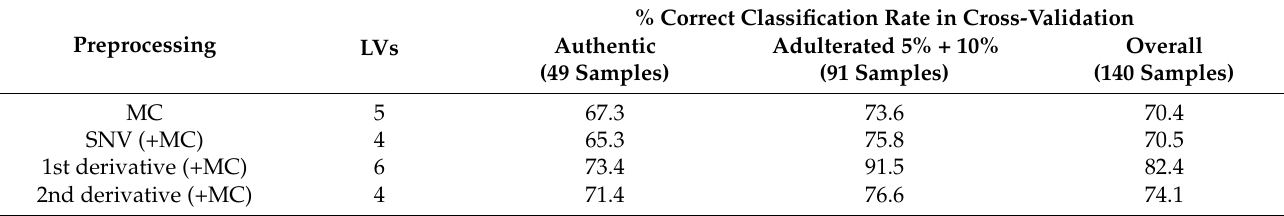
Table 1. Partial least squares discriminant analysis (PLS-DA) classification of authentic vs. 5% + 10% adulterated samples: results of cross-validation for model selection.